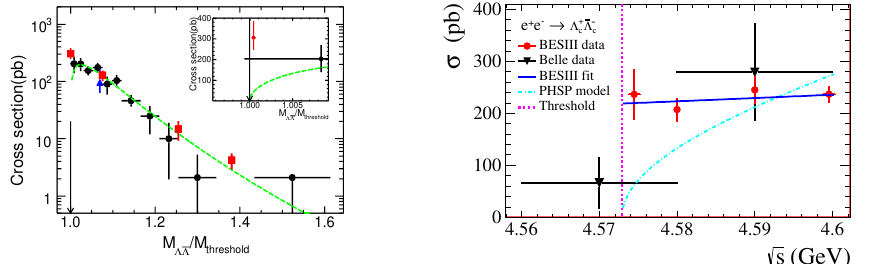
Λ ¯ Λ from BESIII (red), BaBar →